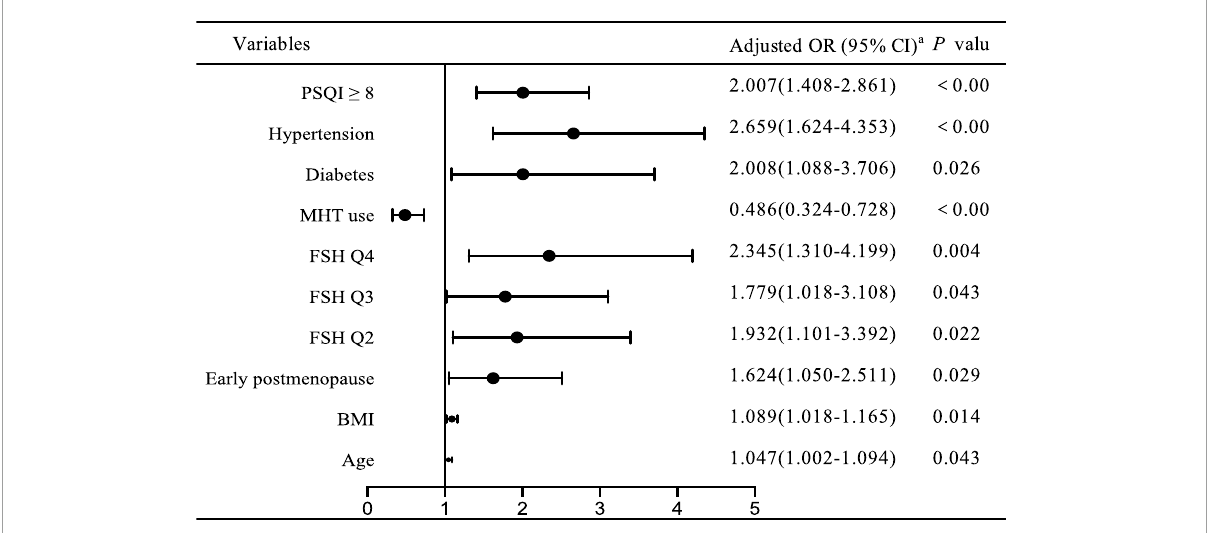
FIGURE1 Adjusted odds ratio for declining renal function by logistic regression a adjusted for age, BMI, menopausal status, years since menopause, SBP, FBG, lipid profiles, hypertension, diabetes, obesity, MetS. OR, odds ratio; CI, confidential interval.